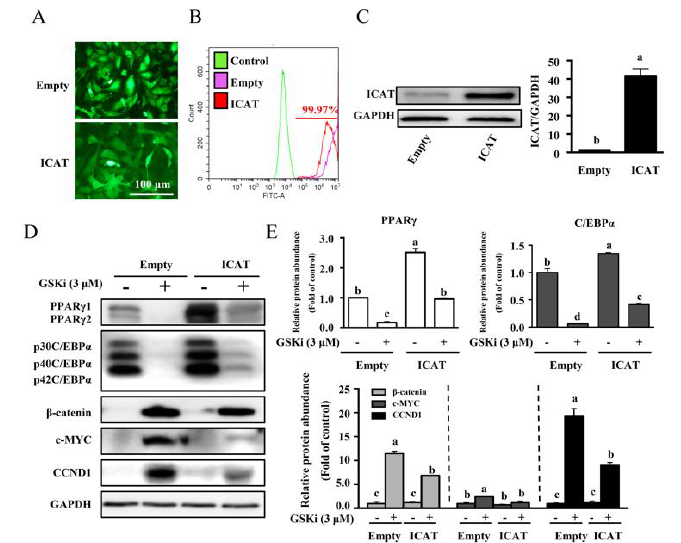
Figure 3. ICAT overexpression inhibited the Wnt / β -catenin signaling targets, but upregulated protein levels of adipogenic regulators upon the CHIR99021 induction. ( A ) 3T3-L1 pre-adipocytes infected with lentivirus carrying ICAT. ( B ) 3T3-L1 pre-adipocytes stably overexpressing ICAT sorted by flow cytometry. ( C ) Protein expression for ICAT in stable overexpressing cells. ( D ) Protein expressions and ( E ) abundance analysis for adipogenic regulators and Wnt / β -catenin targets in 3T3-L1 adipocytes